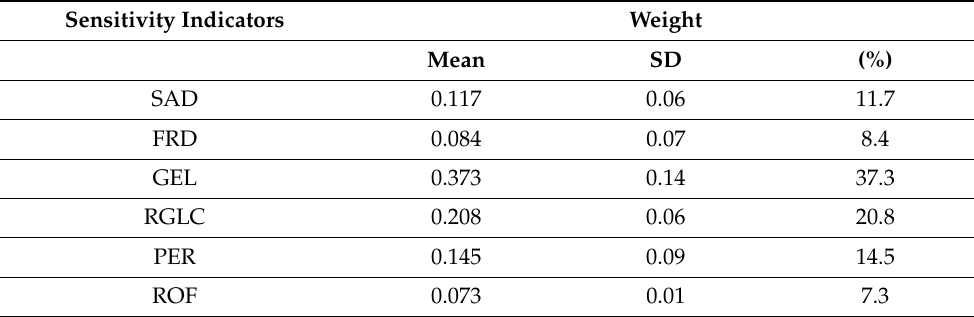
Figure 8. AHP technique application to determine the weights of the six sensitivity indicators. Red crosses indicate the mean weight computed by averaging the weights obtained from each expert. Table 4. Weights assigned to each sensitivity indicator resulting from the AHP process: mean, standard deviation (SD), and percentage.